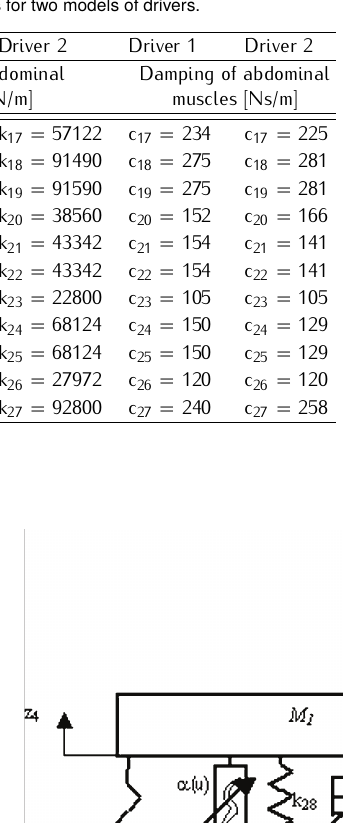
Table 5. Stiffness and damping of abdomen muscles for two models of drivers.